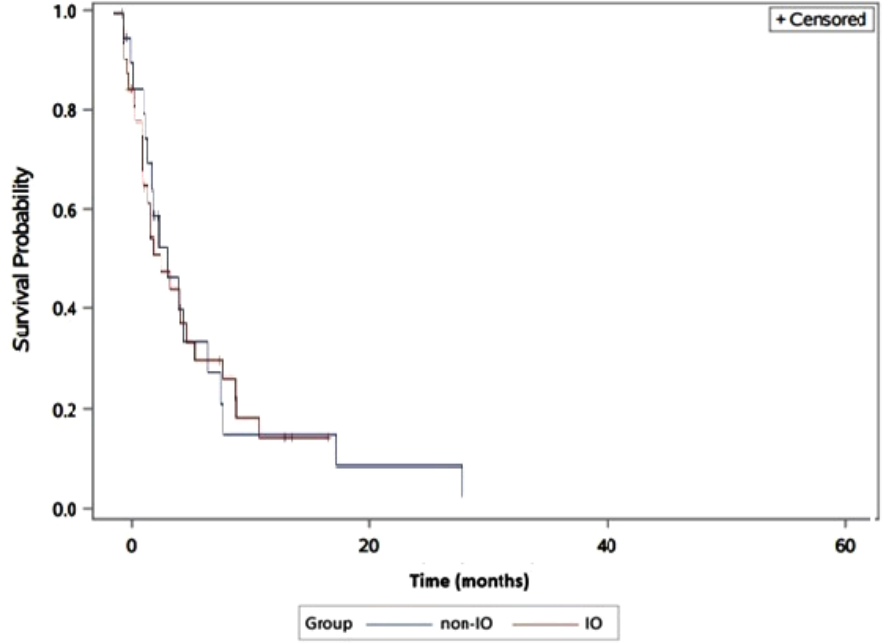
Figure 1. Progression-free survival in immunotherapy (IO) versus non-IO subgroups. The blue line represents the non-IO whereas the red line represents the IO population.